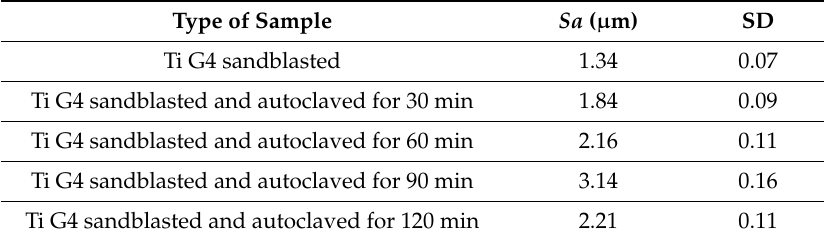
Table 7. Sa parameter defined as arithmetical mean height of the scale limited surface evaluated over the complete 3D surface in accordance with ISO 25178–2 [63] for the Ti G4 before and after autoclaving. Type of